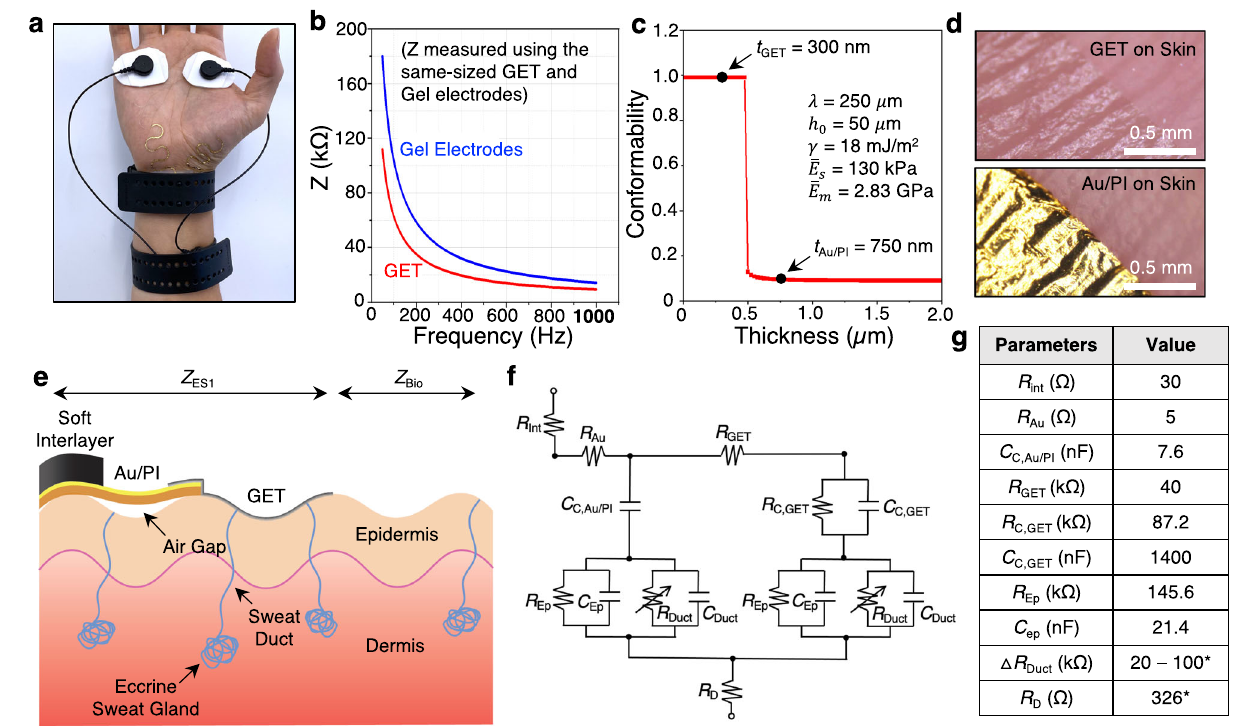
Fig. 4 | Electrode-skininterface impedance modeling and characterization. a A photograph of HSPR and gel electrodes connected to two identical E4 wristbands. b Impedancevs.frequencymeasuredforGET(blue)andgelelectrodes(red)ofthe same size. c Analytical prediction of conformability of PMMA or PI on the skin depending on its thickness. d Micrographs of 300-nm-thin GET (top) and 750-nm- thin Au/PI (bottom) laminated on human skin. It is obvious that only GET can fully